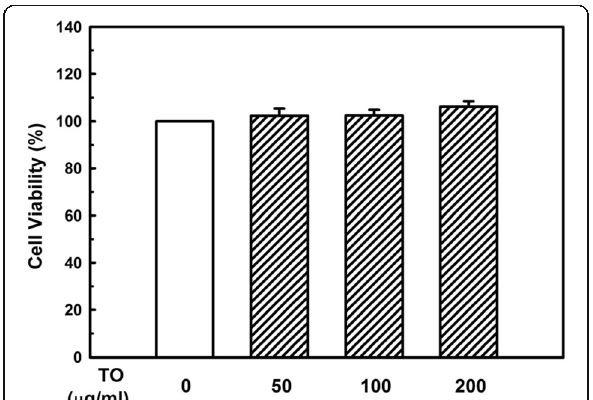
Fig. 1 Effect of the Taraxacum officinale (TO) methanol extract on the viability of HUVECs. Cells were treated with different concentrations of the TO extract for 24 h, and viability was determined by the MTS assay. The results of independent experiments were averaged as the percentage cell viability compared with untreated control. Results shown are the mean ± SE of triple